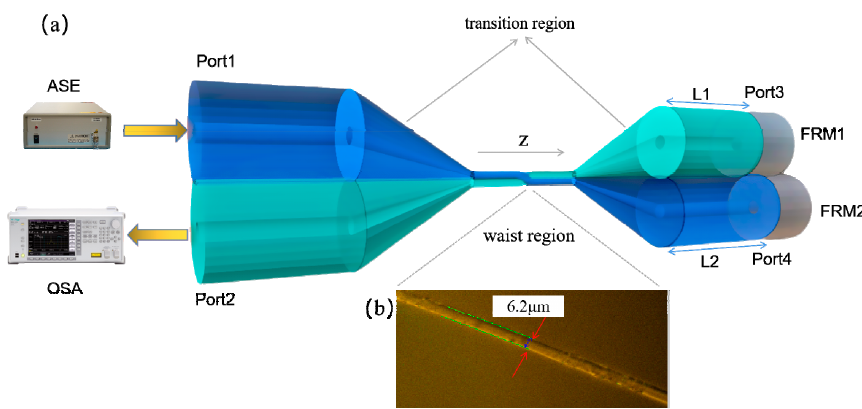
Figure 1. ( a ) Schematic of OMCI composition; it is constructed by connecting two faraday rotating mirrors to port3 and port4 of the OMC, respectively, the amplified spontaneous emission (ASE) broadband light source injecting to port1 and monitoring the signal from port2 by using the optical spectrum analyze (OSA). ( b ) Microscopic image of the OMC waist